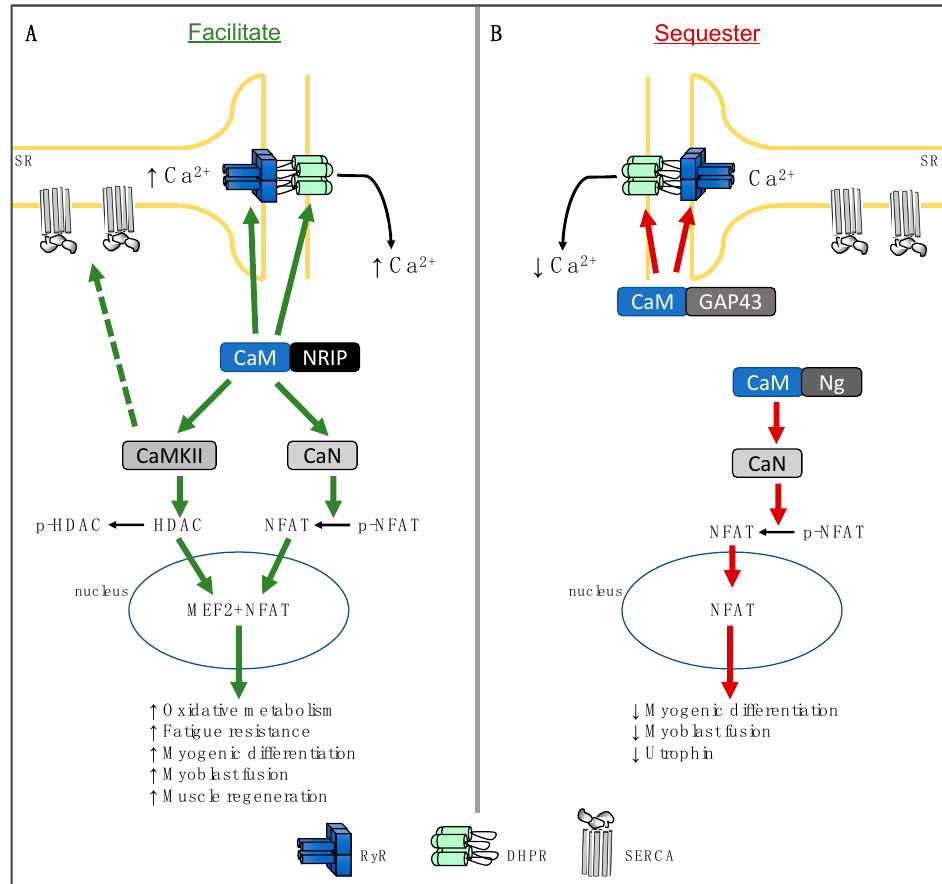
Figure 1. Simplified scheme of the physiological roles of calmodulin (CaM)-binding proteins, nuclear receptor interacting protein (NRIP), neurogranin (Ng), and growth-associated protein 43 (GAP43) in skeletal muscle. ( A ) CaM-binding proteins that facilitate CaM binding with its downstream targets leads to their subsequent activation (green arrows). Recent evidence has revealed a role for NRIP in facilitating CaM binding to ryanodine receptor (RyR) and dihydropyridine receptor (DHPR), thereby contributing to increased sarcoplasmic reticulum (SR) Ca 2+ release [9] . NRIP also facilitates CaM binding and activation of CaMKII and CaN. Activated CaMKII phosphorylates class-II histone deacetylases (HDACs), thereby activating myocyte enhancer factor 2 (MEF2). CaN dephosphorylates nuclear factor of activated T-cell (NFAT), leading to its nuclear entry. Together MEF2 and NFAT increase the expression of genes associated with oxidative fibre type, fatigability, myogenic differentiation, myoblast fusion, and muscle regeneration [9] . The dashed green arrow illustrates the hypothetical scenario by which enhanced CaM-dependent kinase II (CaMKII) activation with NRIP can lead to increased SERCA-mediated Ca 2+ uptake, thereby enhancing total SR Ca 2+ potentially by phosphorylating phospholamban (not shown here) and relieving its inhibition of SERCA. ( B ) CaM binding proteins that sequester CaM away from its downstream targets lead to a subsequent reduction in their activation (red arrows). Ng binds to CaM and prevents its binding to CaN, leading to a reduction in myogenic differentiation, myoblast fusion, and utrophin expression [28] . GAP43 binds to CaM and prevents it from binding to RyR and DHPR, thereby reducing SR Ca 2+ release. The role of NRIP in maintaining normal cardiac function [11] is not shown here.